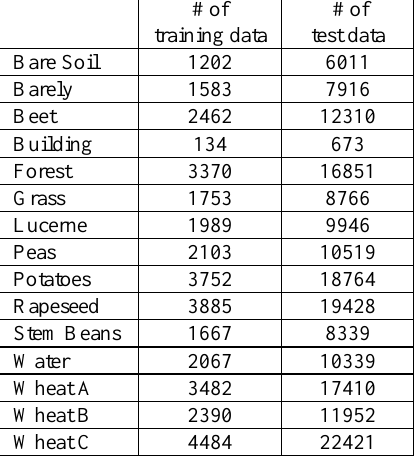
Table 2. The number of training and test